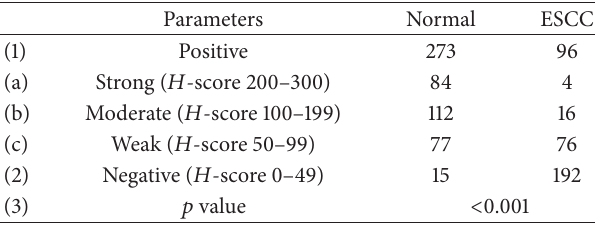
Table 1: Summary of IHC labeling for S100 calcium binding protein A9 (S100A9) in normal and ESCC